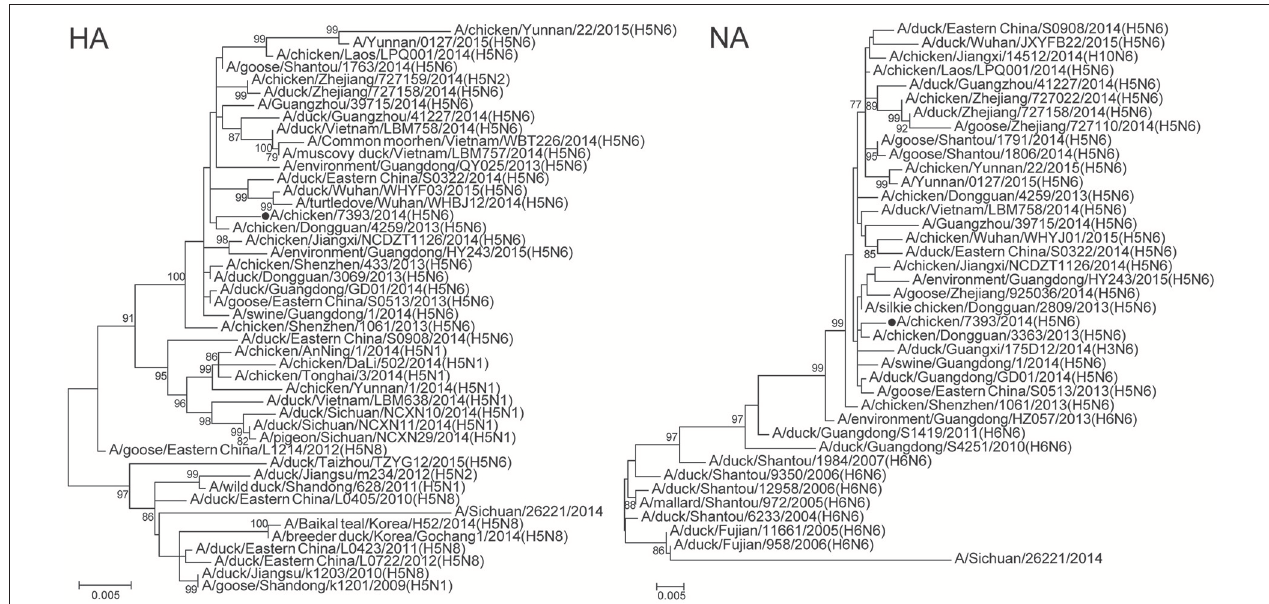
FIGURE 3 | Phylogenetic tree of hemagglutinin (HA) and neuraminidase (NA) genes of influenza A (H5N6) viruses isolated from sentinel chickens, Wuxi City, Jiangsu Province of China, 2014. Supporting bootstrap values > 75 are shown. The black circle dot indicates the viruses isolated in present